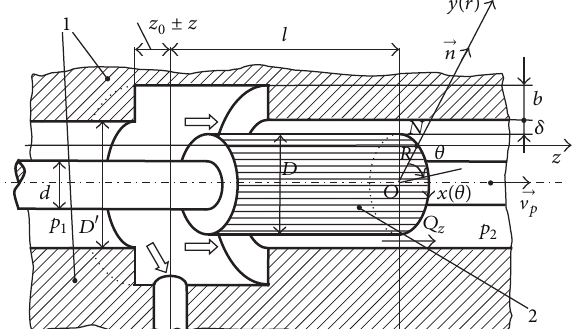
Figure 1: Constructive elements of the controllable turbulent hydraulic resistance with cylindrical slide-valve.